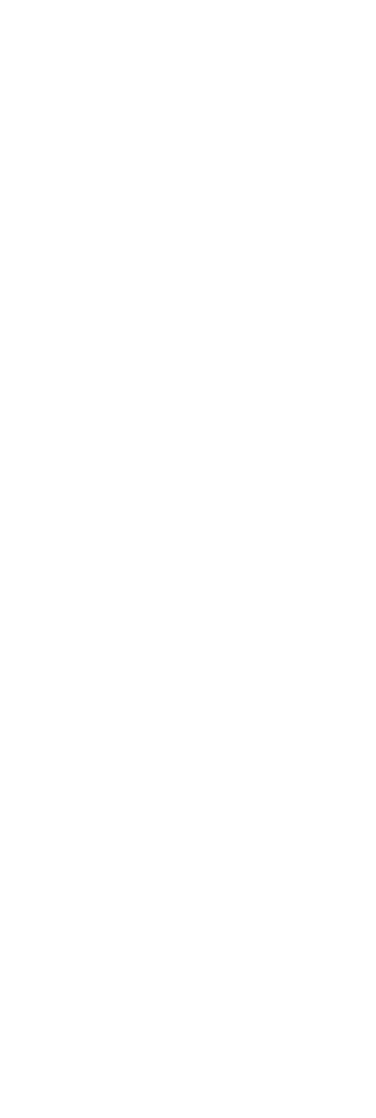
FIGURE 5 | Sensitivity analysis for (A) clinically signi fi cant prostate cancer detection (B) clinically insigni fi cant prostate cancer detection (MRI-TB vs. systematic biopsy). The circles represent the RR estimate and the horizontal lines represent the 95% CI. CI, con fi dence interval; RR, relative